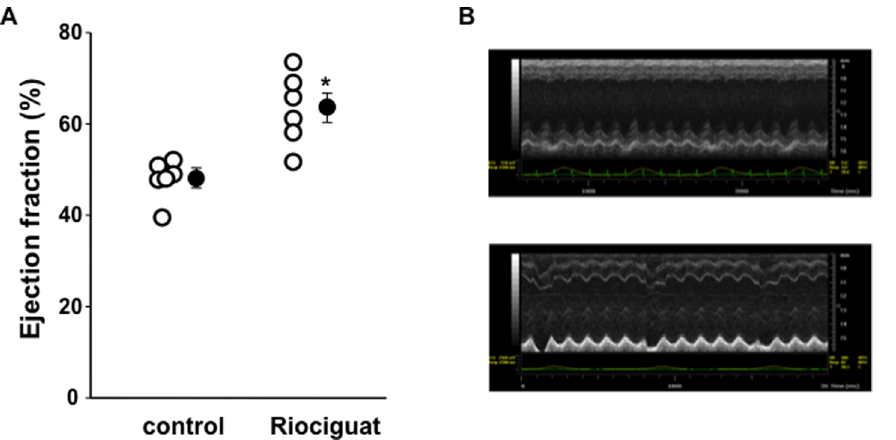
Figure 4. Improvement of LV ejection fraction following riociguat treatment 28 days post-MI . ( A ) Early riociguat treatment continued to result in improved LV ejection fraction, suggesting beneficial effects on post-MI remodelling. * p , 0.004. ( B ) Representative images of M-mode traces of control (top) and riociguat treated (bottom) mice hearts.